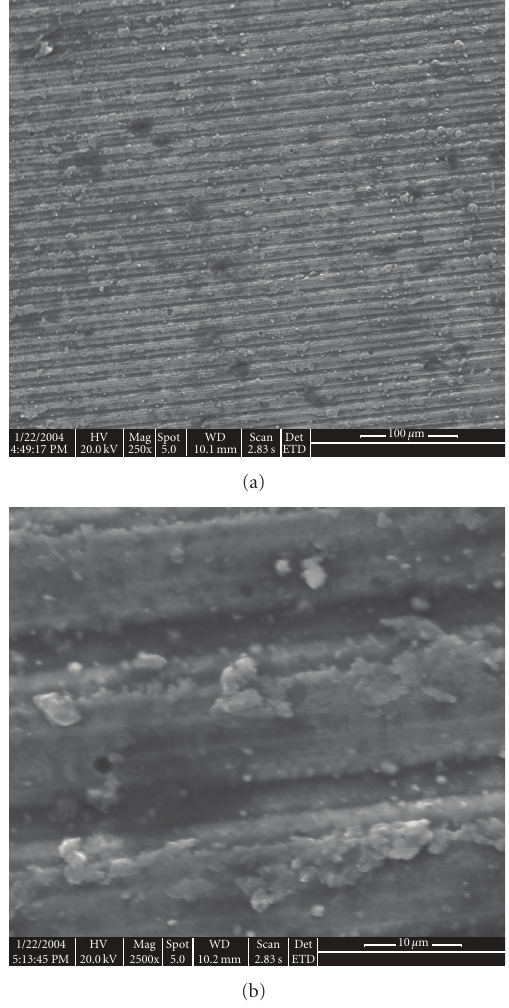
Figure 10: Enlarged SEM images of the zone marked as 2 in Figure 8. Notice the film